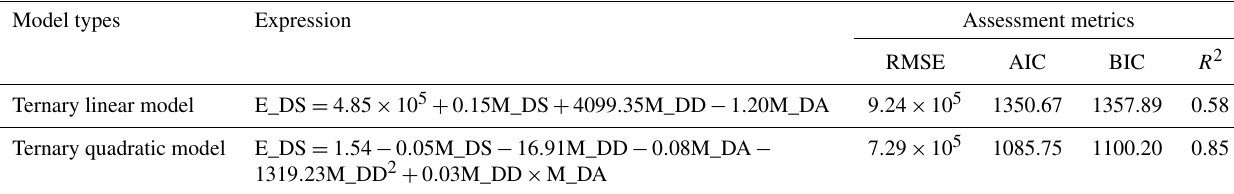
Figure 10. Conditional probability of ecological drought at (a) extreme, (b) severe, and (c) moderate levels, given that characteristics of meteorological drought exceed a certain value. Table 8. E_DS with polynomial functions based on meteorological drought